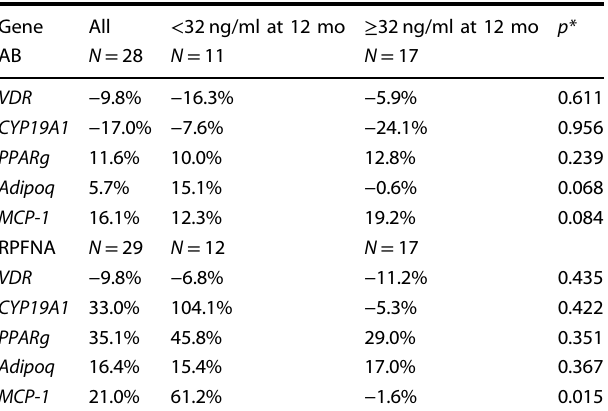
Table 4. Twelve-month change in gene expression (unsupervised) according to vitamin D repletion status (25(OH)D < / ≥ 32 ng/mL) among women randomized to 2000 IU vitamin